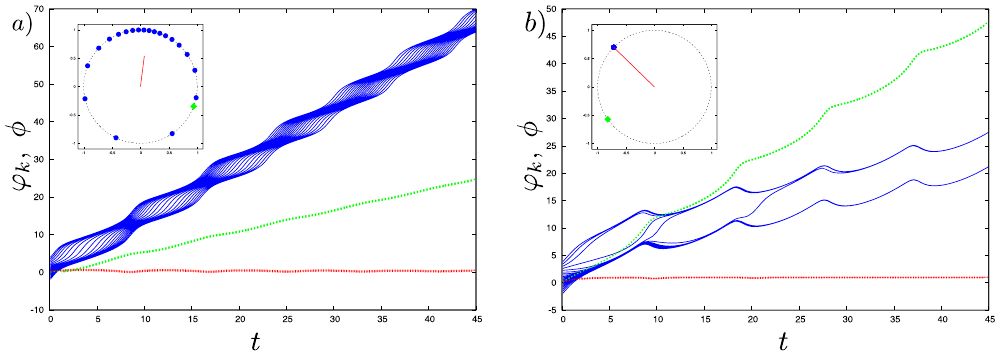
Figure 3. Simulation of system (4) for N = 20 oscillators with the parameters A = B = 1, α β π = = . 0 3 . In panel a) we show that an asynchronous hub can actively desynchronize the peripheral oscillators when an attractive mean-field is applied ( C = 0.5, γ = 0.2 π , ω = 2 and ω 0 = 0.6). In panel b) we show the emergence of remote synchrony in the presence of a repulsive mean-field applied to the peripheral oscillators ( C = 1, = 1.4). Time-dependence of the phase of the leader φ t ( ) (dashed green line), the phases γ π = . 0 6 , ω = 1 and ω 0 ϕ t ( ) of the leaves (solid blue lines) and their order parameter (dotted red line). Note that the difference between k the blue branches on panel b) is exactly 2 π . (Insets) Snapshots of the oscillators. The leaves are represented as blue circles and the leader as a green diamond; the red line is the order parameter of the